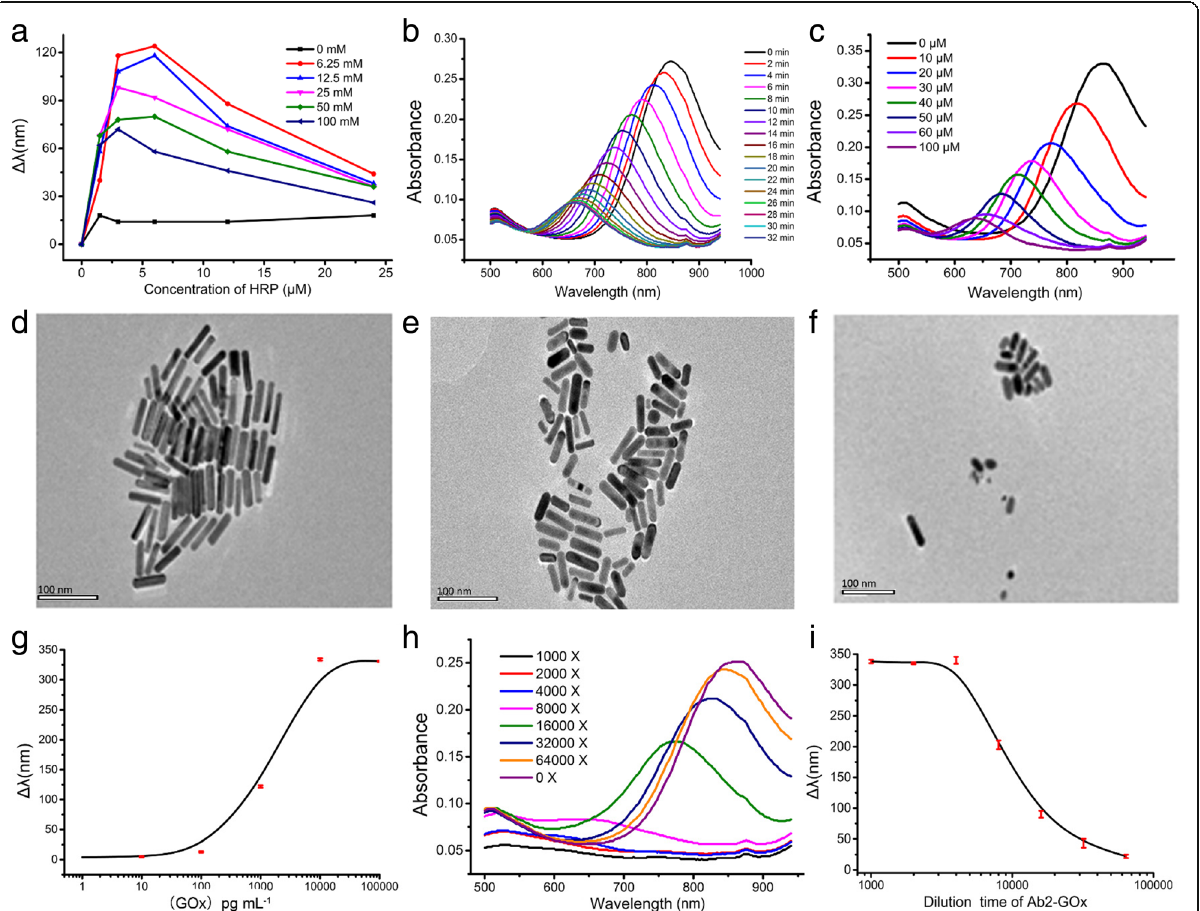
Fig. 2 Optimization and characterization of AuNRs based on plasmonic immunoassay for Myo detection. a Optimization of HRP and CTAB concentration in AuNRs based on plasmonic immunoassay. Different color lines represent different concentrations of CTAB, among which 6.25 mM CTAB and 1.5 μ M HRP were preferred. b Optimization of time for H 2 O 2 etching AuNRs, for which 1.5 μ M HRP, 6.25 mM CTAB, and 100 μ M H 2 O 2 contained in citrate buffer (20 mM, pH 4.0) for 30 min was preferred. c LSPR spectrum of AuNRs with the addition of 50 μ L of varying concentrations of H 2 O 2 . d – f TEM images of AuNRs etched by different concentrations of H 2 O 2 (0 μ M, 10 μ M, and 100 μ M) for 30 min. g LSPR shift of AuNRs under different concentrations of GOx. h LSPR spectrum of AuNRs in the presence of GOx-Ab2 at different dilution ratios. i LSPR spectrum shift of AuNRs in the direct plasmonic immunoassay coated with different concentrations of Myo. Each value presents the mean from three